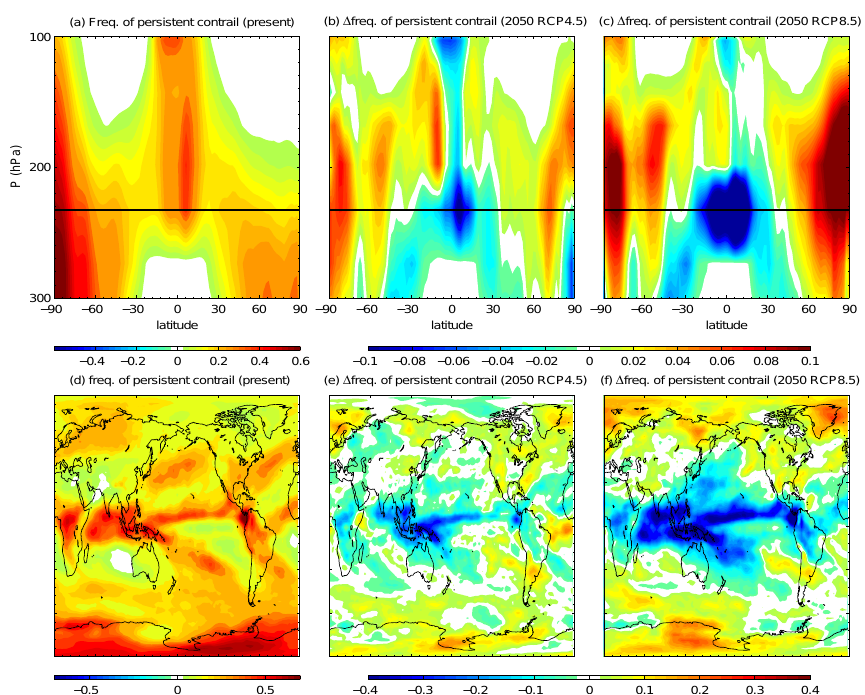
Figure 2. Frequency of persistent contrail based on present and future (RCP4.5 in 2050 and RCP8.5 in 2050) meteorologies: (a) zonal average between 100 and 300hPa, (b) zonal difference between 2050 of RCP4.5 and present, (c) zonal difference between 2050 of RCP8.5 and present, (d) the present condition at P = 232hPa, (e) difference between 2050 of RCP4.5 and present at P = 232hPa and (f) difference between 2050 of RCP8.5 and present.